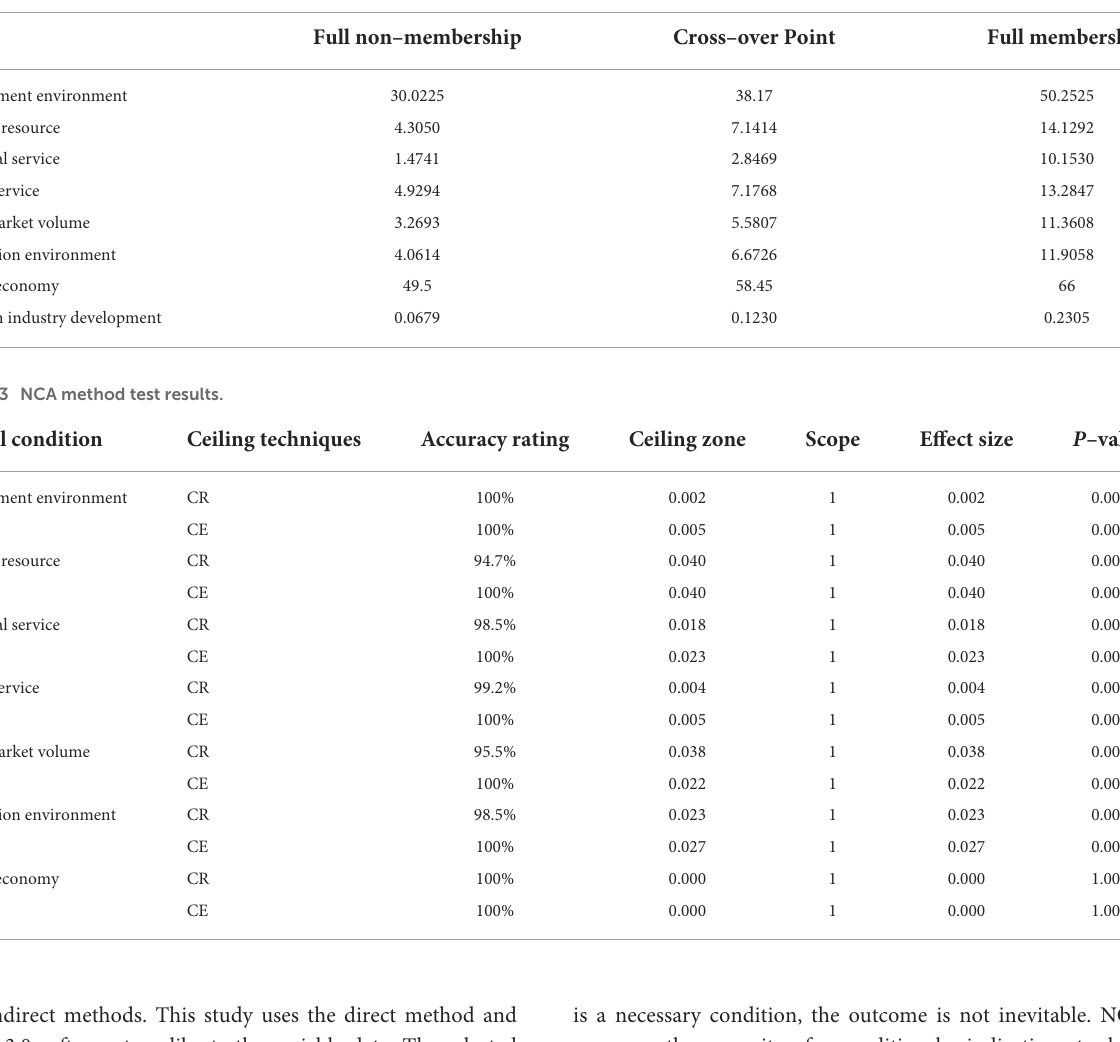
TABLE 2 Variable calibration value.